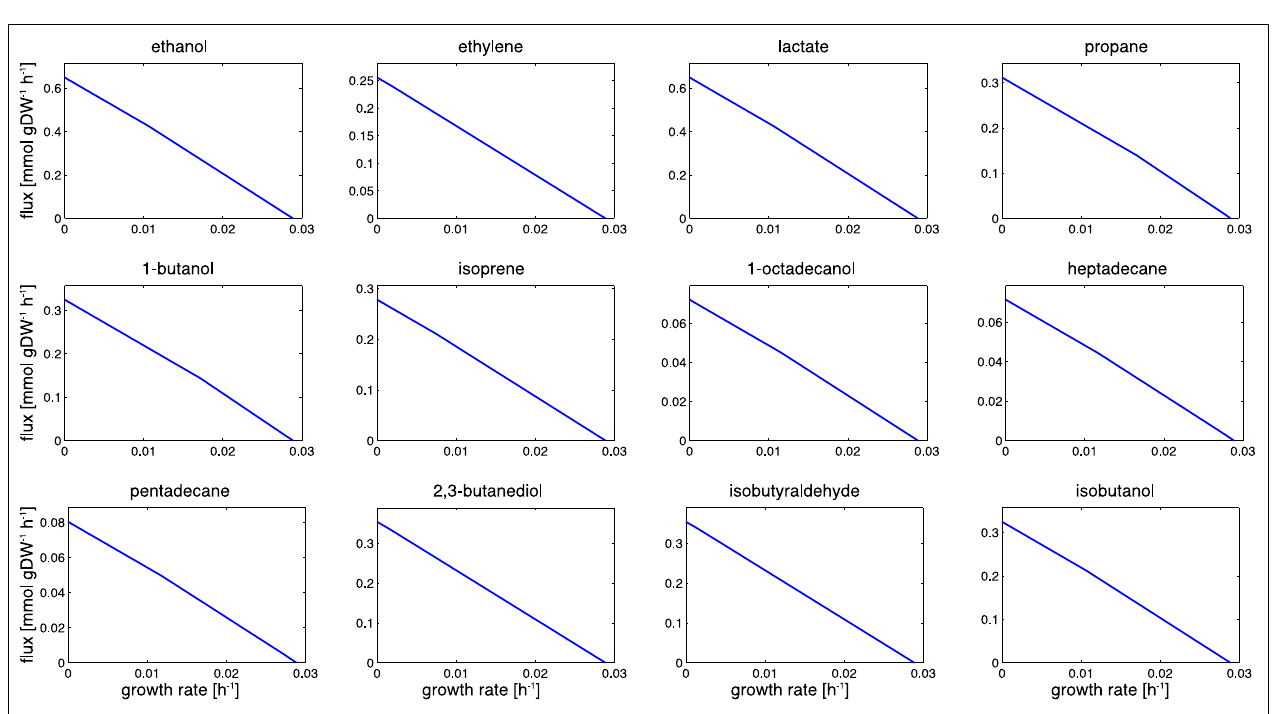
and stoichiometrically feasible, the curves itself represent the line of maximal resource utilization. The observed shapes are slightly convex. We note that the computational analysis does not incorporate the sink effect, where the introduction of an additional carbon sink may also increase the